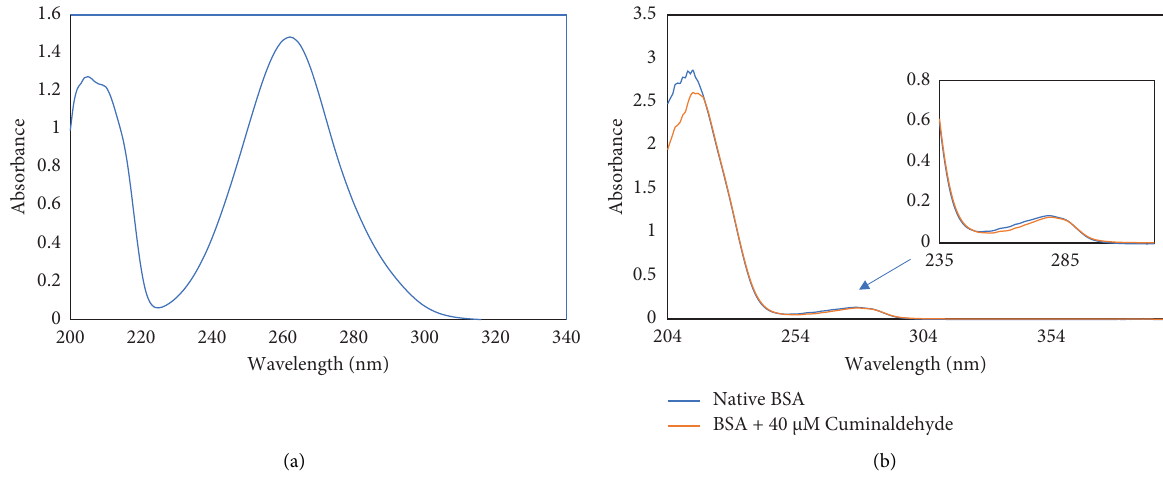
Figure 1: (a) UV–Vis spectrum of 100 μ M cuminaldehyde in a 20mM tris bufer of pH 7.4 at 25 ° C. (b) Diference UV–Vis spectra of BSA (3 μ M) without and with cuminaldehyde in a 20mM tris bufer of pH 7.4 at 25 ° C. Te contribution of cuminaldehyde was subtracted from the spectra of complexes to obtain the diference